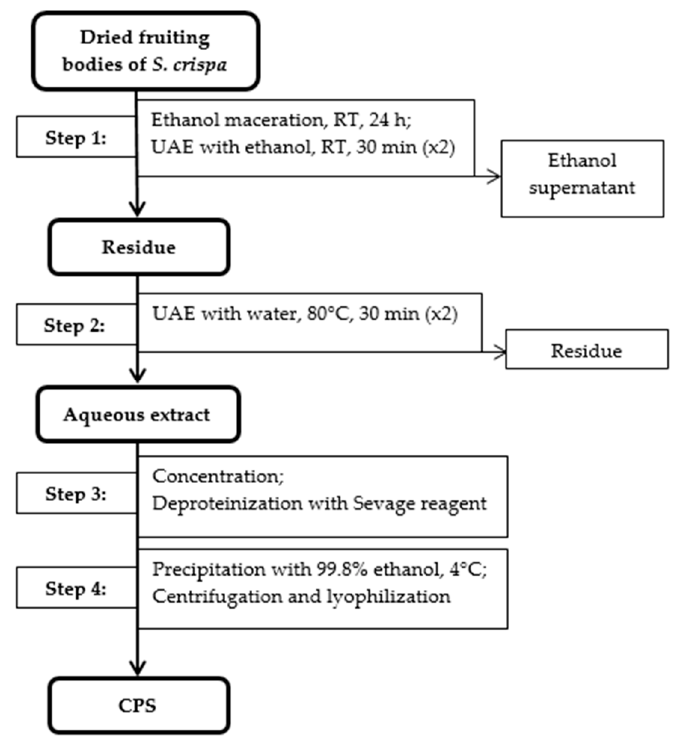
Figure 1. Schematic diagram of extraction of crude polysaccharides from fruiting bodies of S. crispa (CPS). Abbreviations: RT—room temperature; UAE—ultrasonic-assisted extraction.